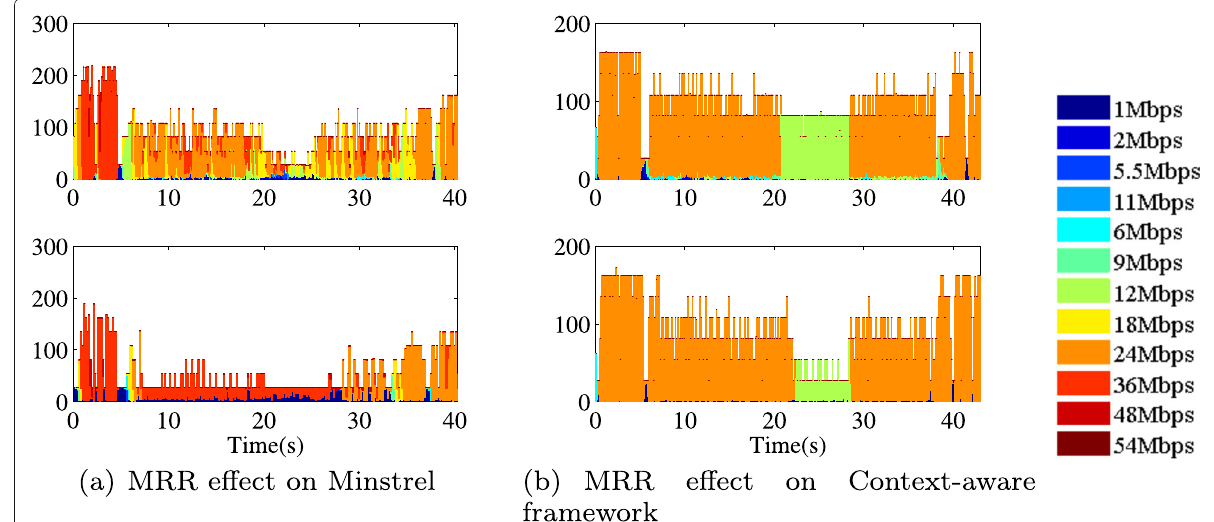
Fig. 7 Effect of MRR. The comparison of the effect of MRR on the throughput performance of Minstrel and the proposed context-aware